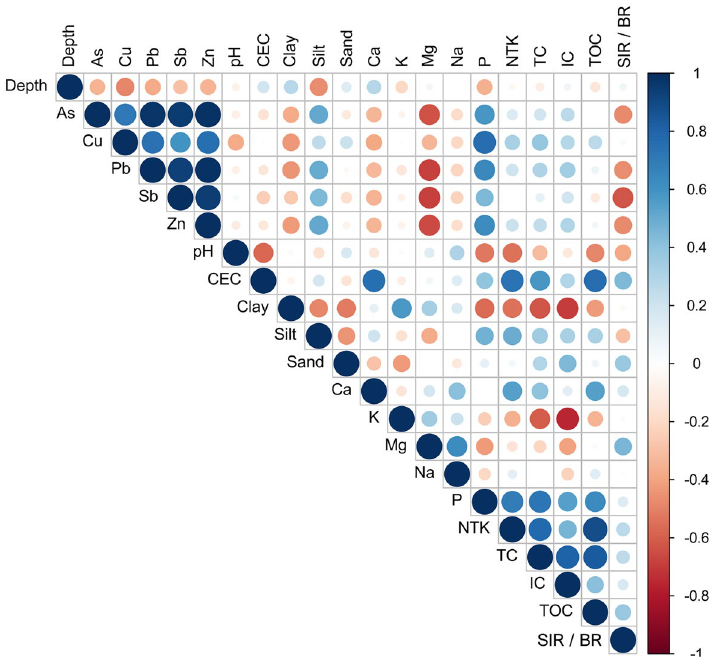
Figure 1. Correlogram of Spearman correlation test performed between pedological properties and soil PTE (metal and metalloid pseudo-total concentrations in mg/kg) measured at both soil depths (0–10 cm and 10–20 cm). Blue dots correspond to the positive correlations and red dots to the negative correlations. The size and color intensity of the dots are proportional to the correlation coefficient value. Parameters: CEC = cation exchange capacity; NTK = total Kjeldahl nitrogen; TC = total carbon; IC = inorganic carbon; TOC = total organic carbon; SIR/BR = substrate-induced respiration/soil basal